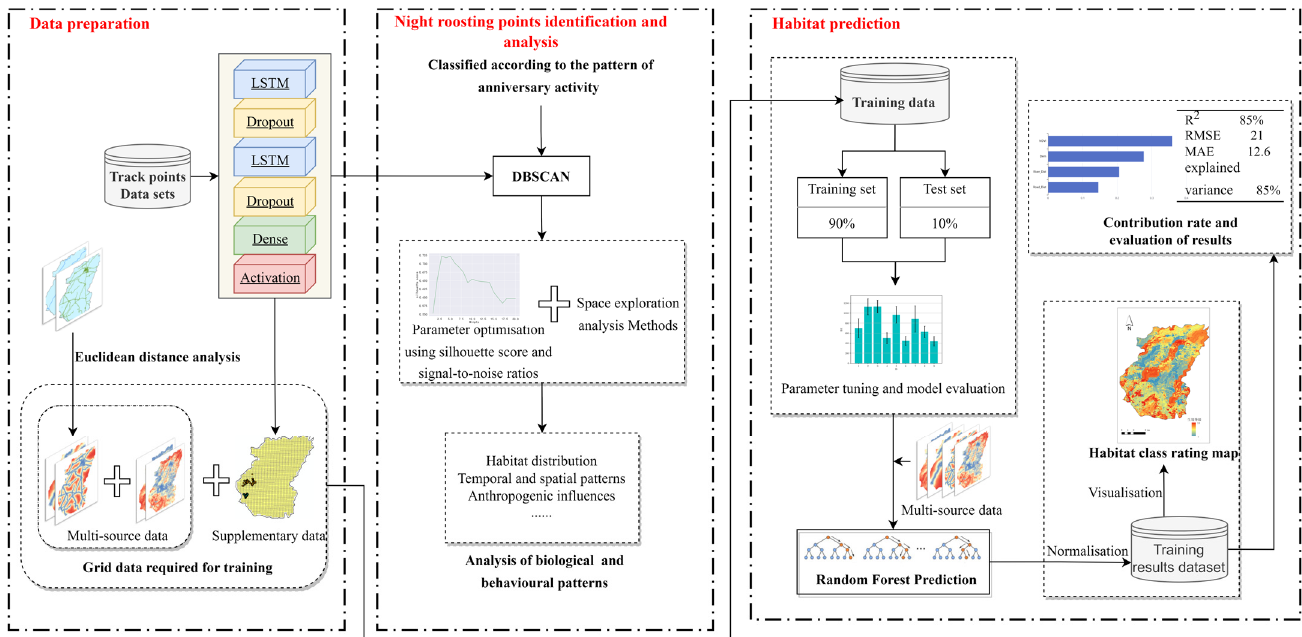
Figure 1. The main methodological framework of the study.